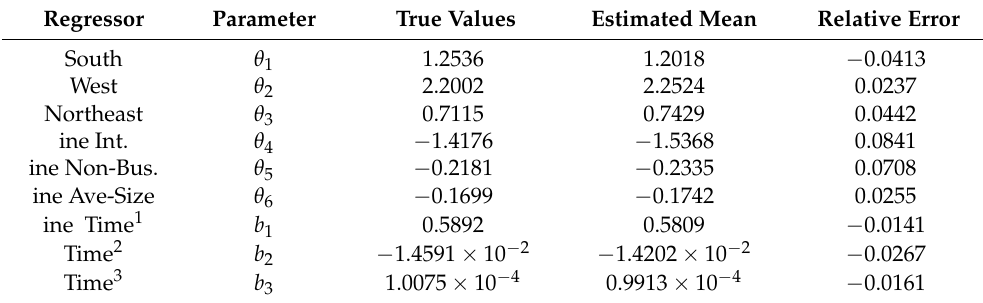
Table 6. Simulation summary